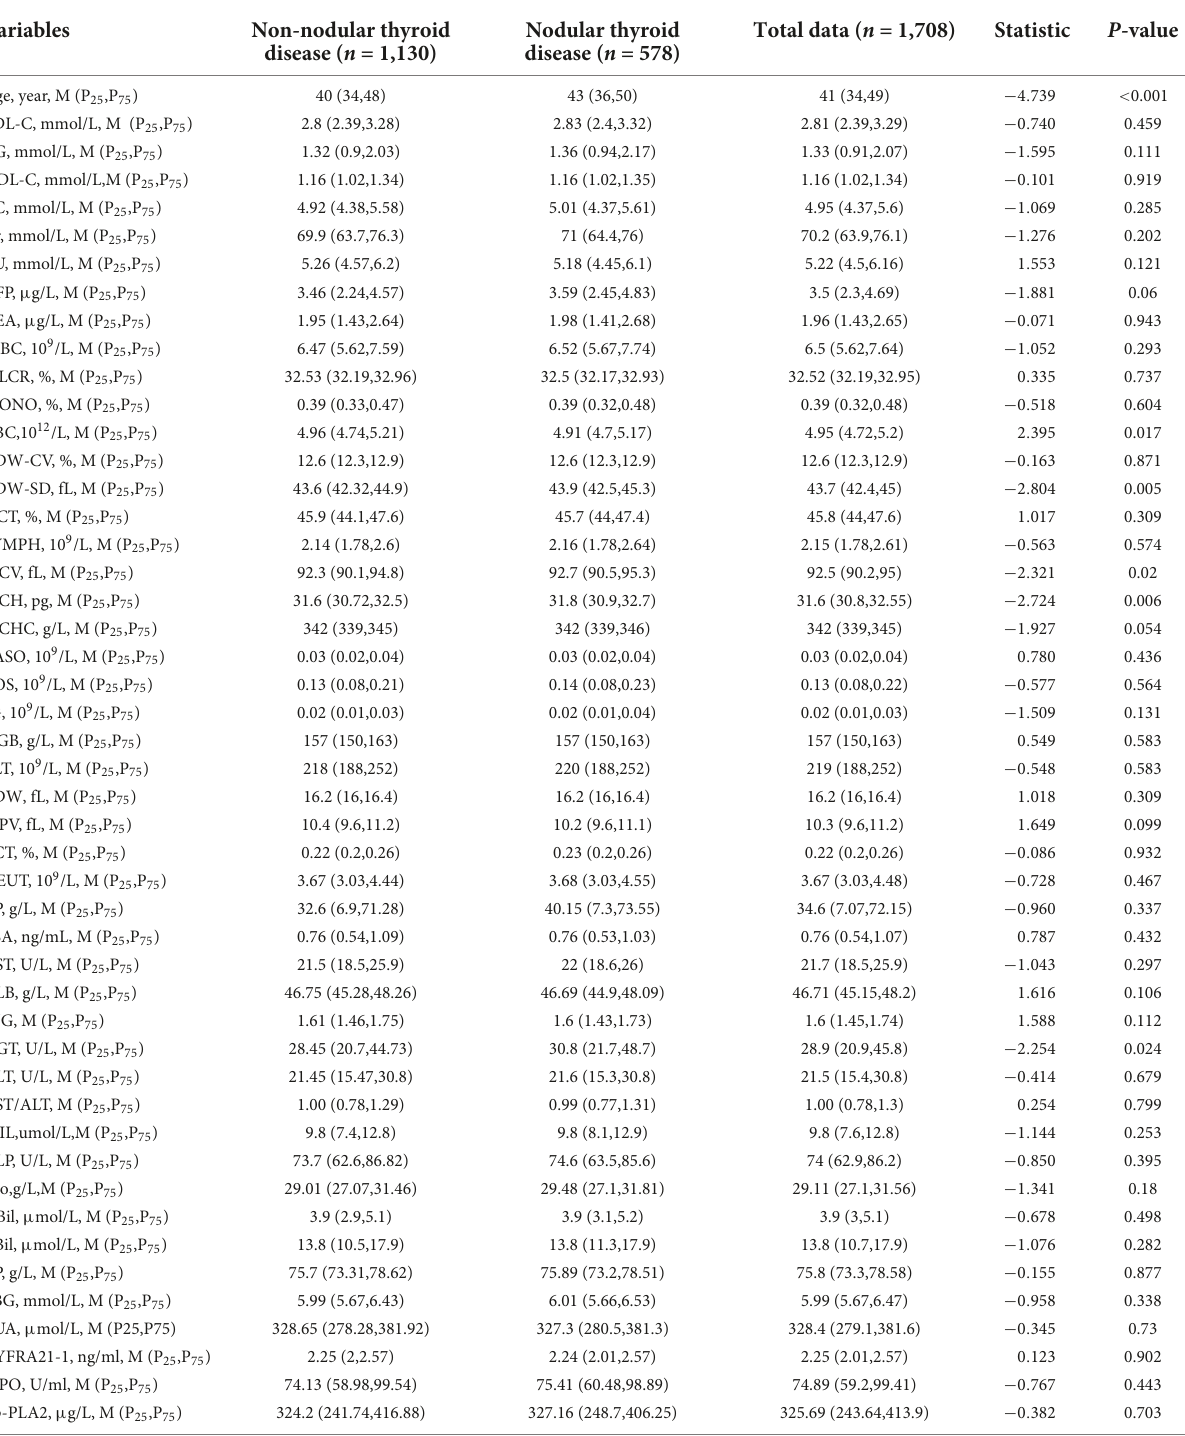
TABLE 1 Baseline clinical characteristics of the two groups of coal